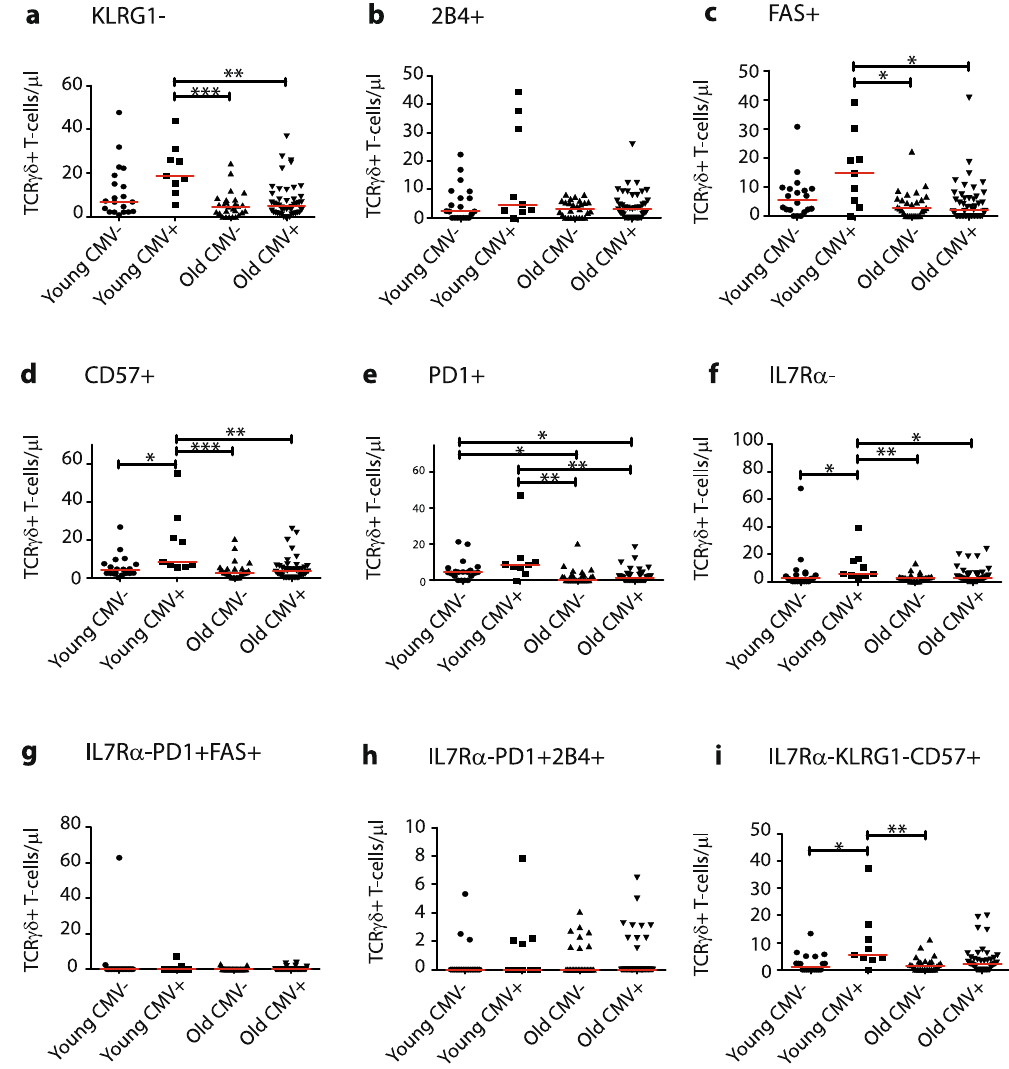
( d ) CD57, ( e ) PD1, ( f ) TCR γδ+ T-cells lacking IL7R α , ( g ) and IL7R α− TCR γδ+ T-cells co-expressing